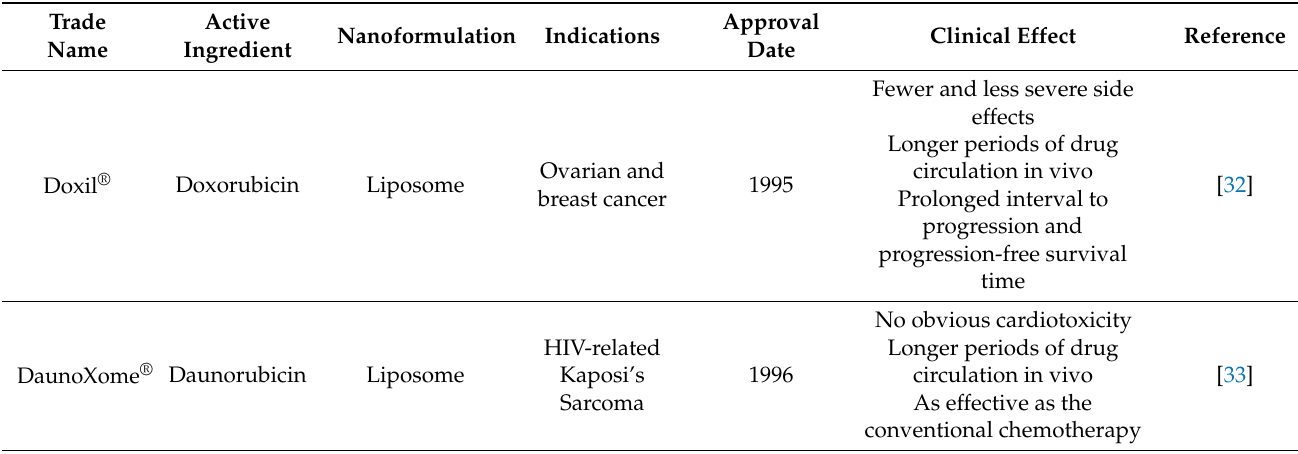
Table 1. Examples of the approved